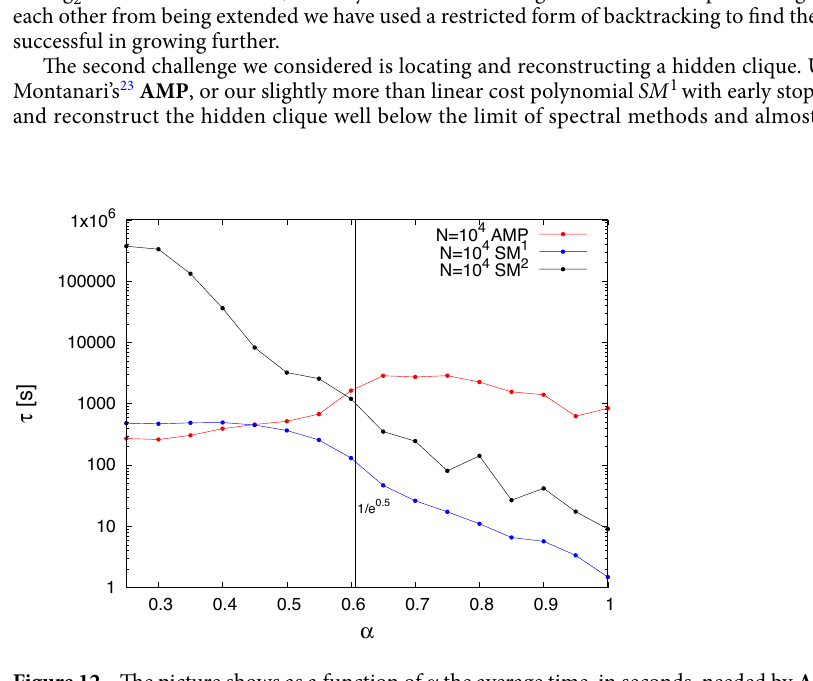
Figure 12. The picture shows as a function of α the average time, in seconds, needed by AMP (red points), and SM 1 (blue points) and SM 2 (black points) with early stopping, to give an answer on a single graph α √ N ) G ( N 10 4 , p 0.5, K HC = = =